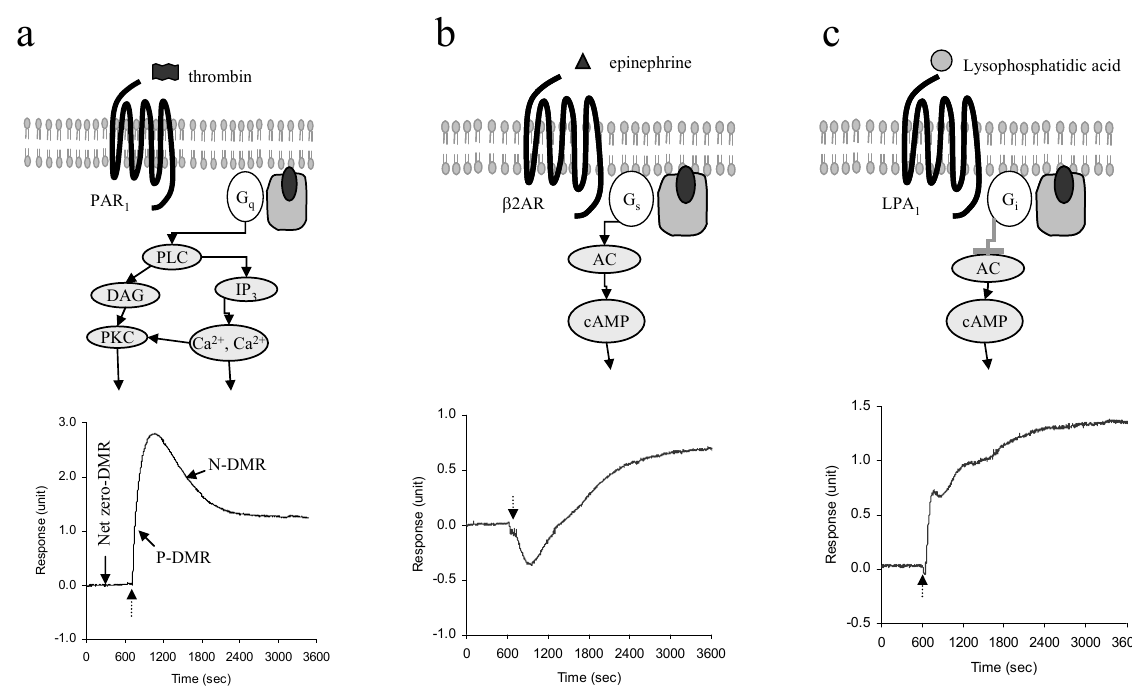
Figure 4. GPCR signaling and three major classes of DMR signals in living cells using RWG -signaling and its DMR signal (protease activated receptor subtype 1 in Chinese biosensor. (a) G q hamster ovary cells, 10 unit/ml thrombin). (b) G -signaling and its DMR signal ( β -adrenergic s 2 receptors in A431 cells, 2nM epinephrine). (c) G -signaling and its DMR signal (lysophophatidic acid i (LPA) receptor subtype 1 in A431, 100nM LPA). The broken arrows indicate the time when an agonist solution is introduced. Data was generated using the angular interrogation system. 1 unit equals to 100 pm shift in resonant wavelength. Figure was reproduced with permission from Ref. 15